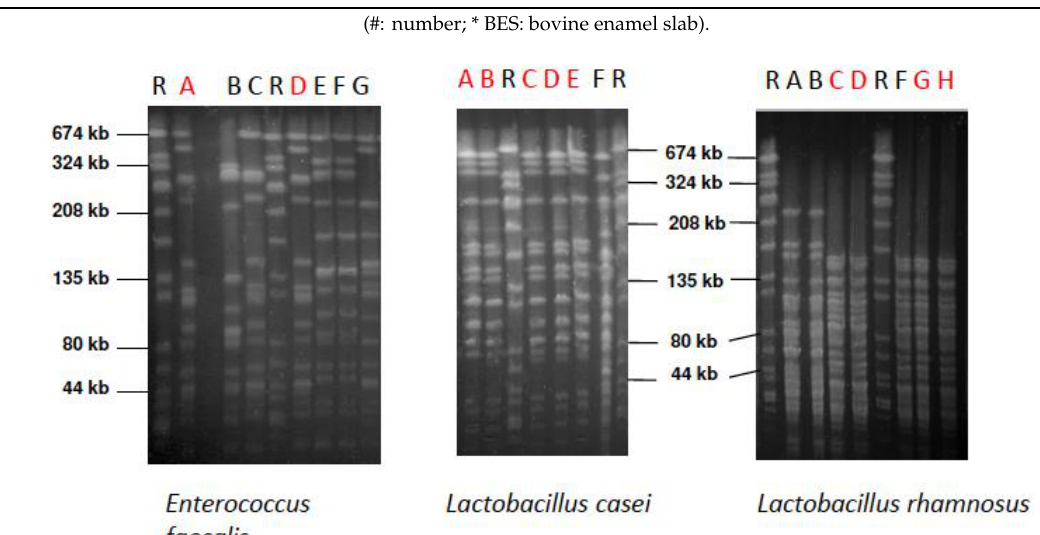
Figure 5. Pulsed-field gel electrophoresis (PFGE) patterns of E. faecalis , L. casei , and L. rhamnosus strains isolated from the supragingival biofilm of the different subjects. Red letters show the strains that were isolated from volunteers and genetically identical to the probiotic product strain. SYM strain: Lane A, ACT strain: Lane B, IINF strain: Lane H. Lane R above the PFGE indicates the reference strain Staphylococcus aureus NCTC 8325.